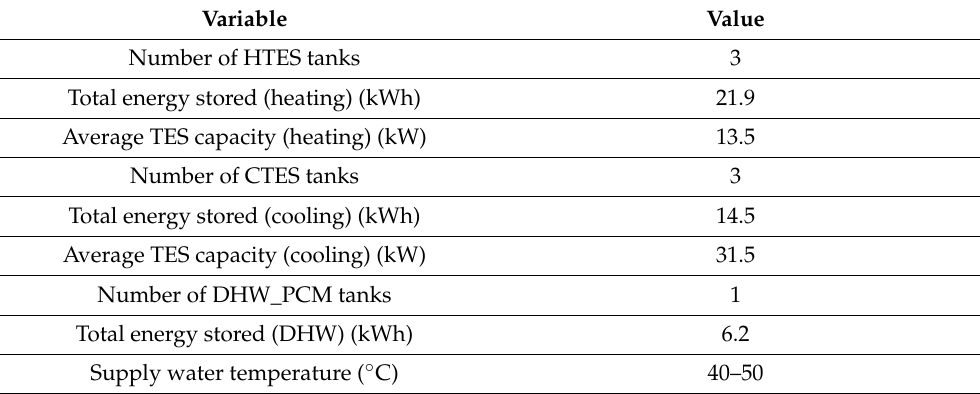
Table 7. Energy stored and energy transfer rate of TES tanks.